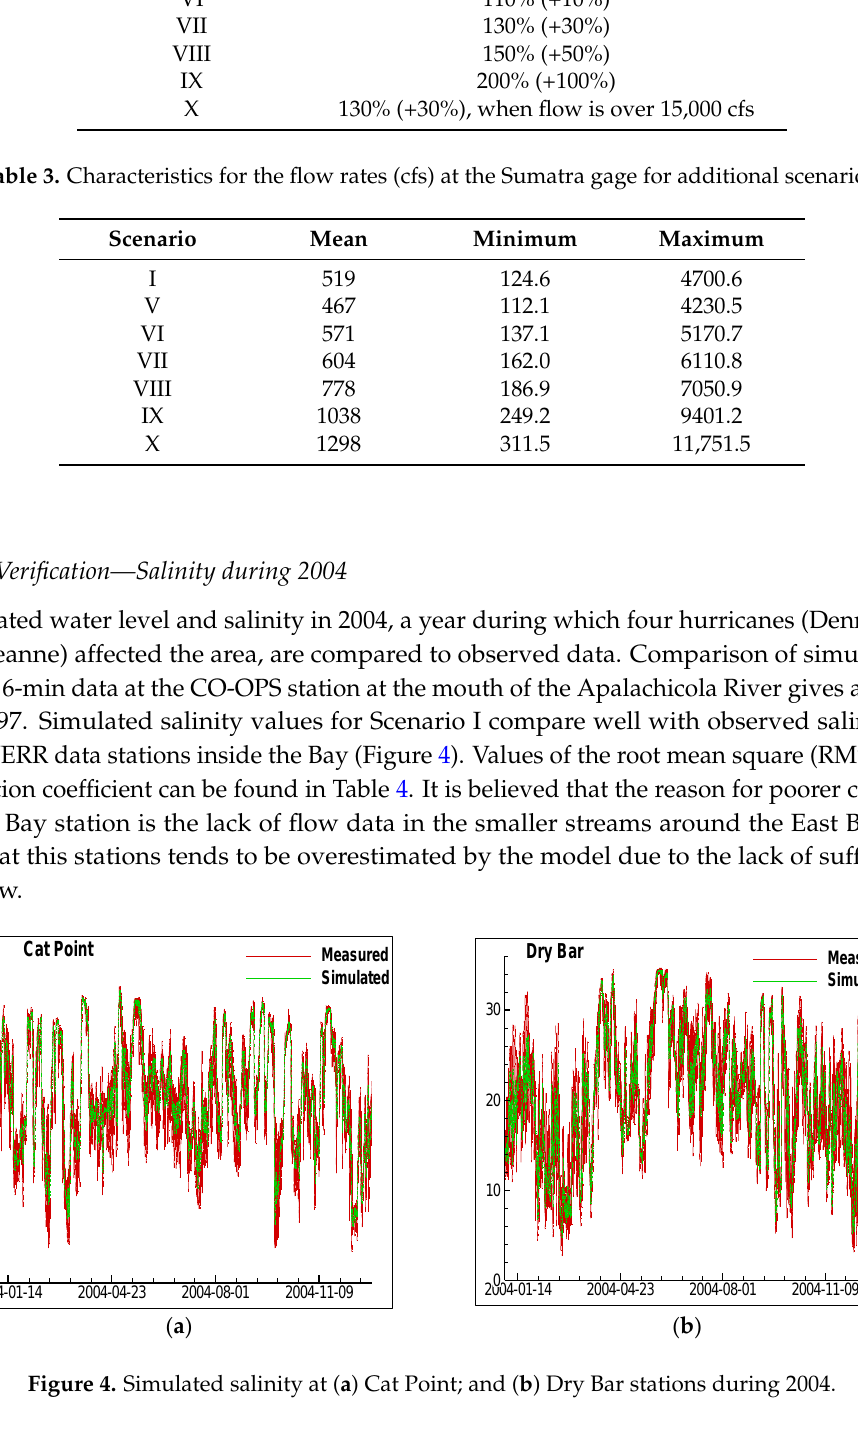
Figure 5. Water level before, during and after Hurricanes Frances, Ivan and Jeanne at Cat Point station. Figure 6. Salinity before, during and after Hurricanes Frances, Ivan and Jeanne at Cat Point station.